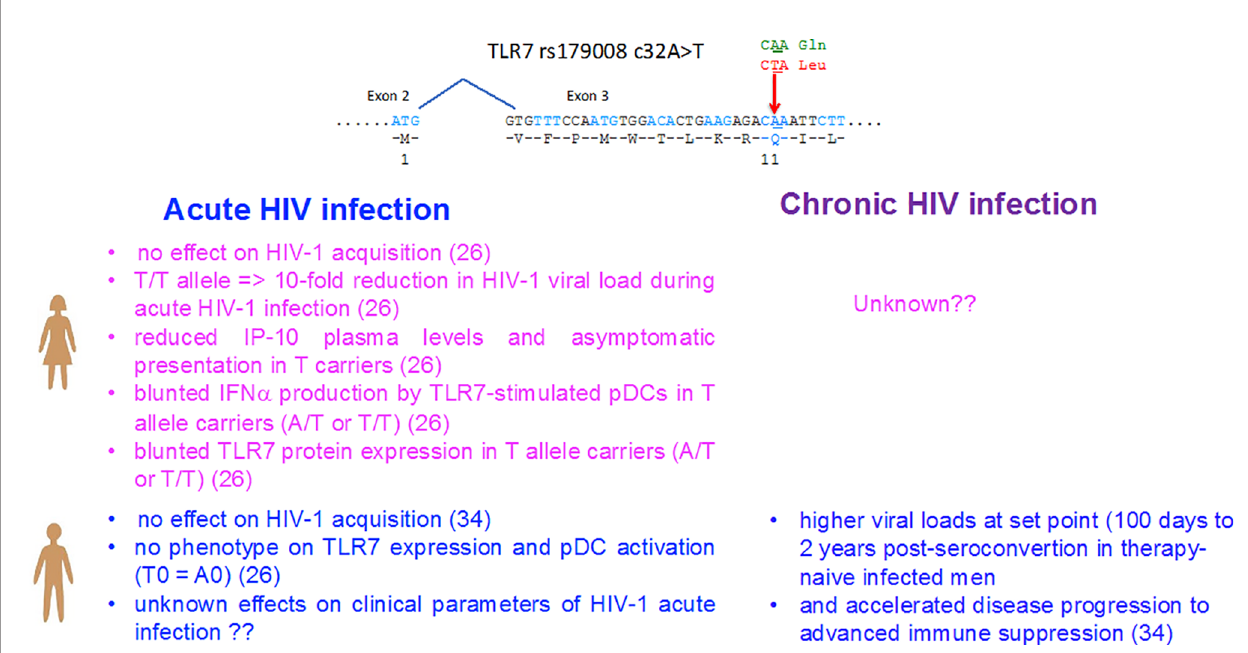
FIGURE 1 | Impact of the sex-speci fi c pQTL rs179008 c.32A/T SNP on TLR7-driven responses and parameters of HIV-1 infection in women and men. The rs179008 SNP is located in the leader sequence of TLR7 at position 32 in codon 11, and introduces an amino acid substitution from Gln to Leu. As shown in ref (26), the minor allele rs179008 T of TLR7 impairs type I interferon production by pDCs in response to TLR7 ligands, but only in women. The sex bias in pDC function mirrors a genotype-dependent drop in TLR7 protein expression in female leukocytes, consistent with the notion that TLR7 dosage in pDCs determines type I interferon secretion. Primary HIV-1 infected women carrying the rs179008 T allele exhibited an almost 10-fold reduction in the RNA viral load, as well as reduction in cell-associated DNA, plasma IP-10, and symptomatic presentation at diagnosis (26). In ref (34), it was initially reported that men carrying the T alleles exhibited higher viral loads at set points compared to A0 men and showed accelerated reduction in CD4 + T cell counts (see Box 1 ). The allelic frequency of rs179008 in the European 1000 Genome project population is 0.76 (A) and 0.23 (T). The genotype frequencies found in our cohorts in average were: Female AA (62%), AT (33%), TT (5%), Male A0 (73%), T0